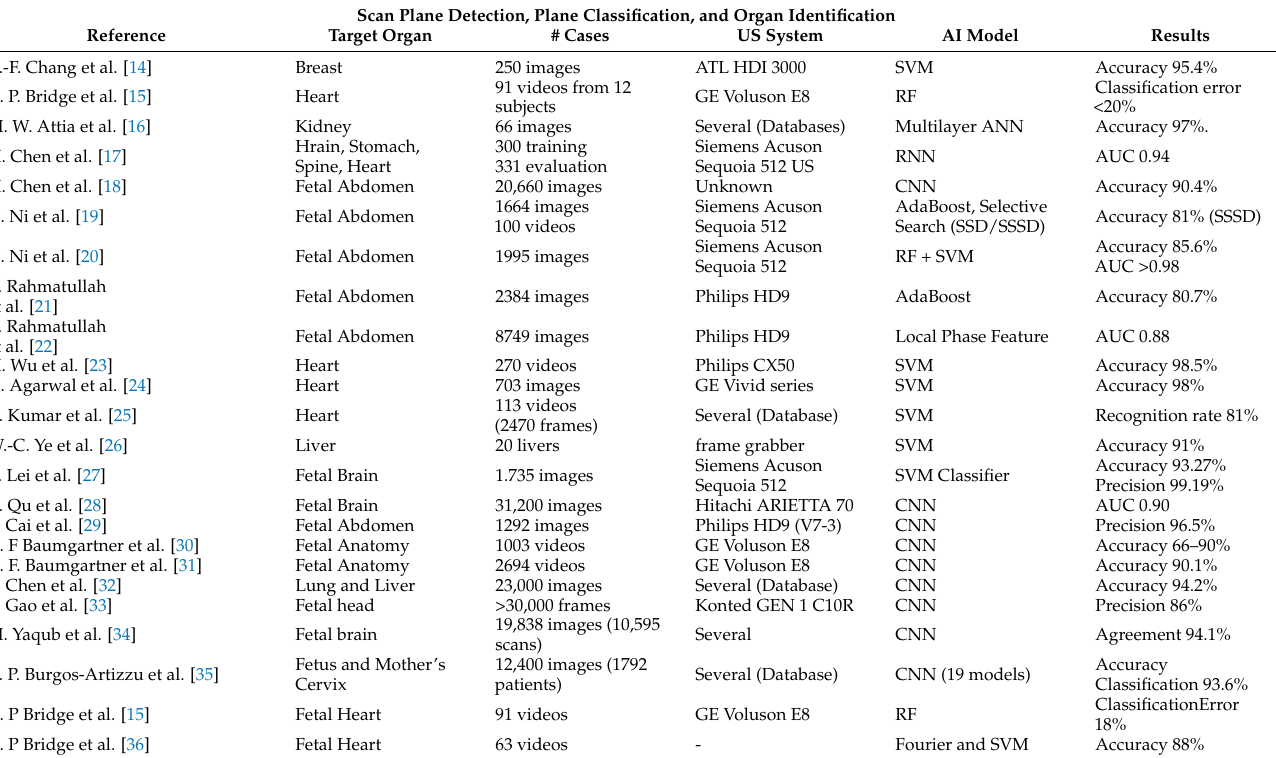
Table 1. Summary of the selected publications on scanning, plane detection, plane classification, and organ identification. Scan Plane Detection, Plane Classification, and Organ Identification